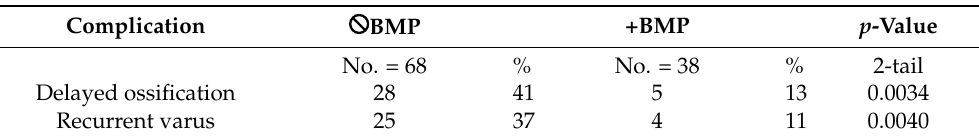
Table 4. Comparison of complications in primary SH: non-fixed angle + no BMP2 (group 1) vs. fixed angle + BMP2 (group 3). Table 6. Comparison of complications in all SH (primary + revision): no BMP (groups 1 and 2) vs. + BMP (group 3).